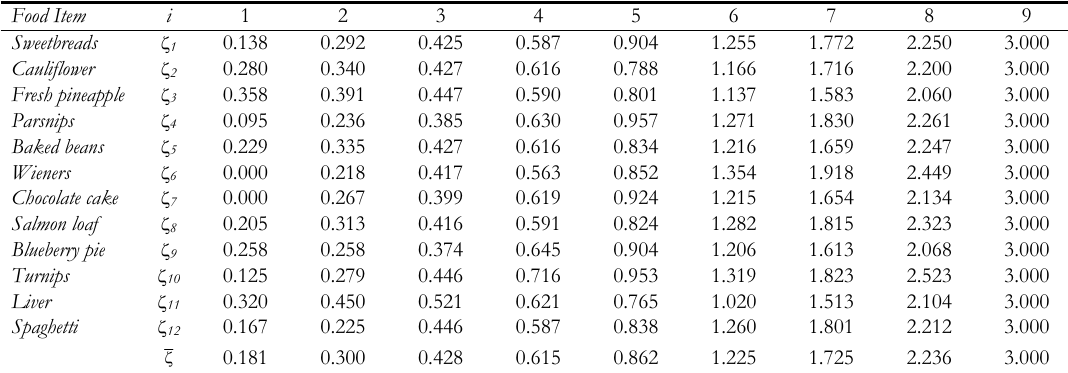
Optimized percentage points for the Logistic-Weibull distribution